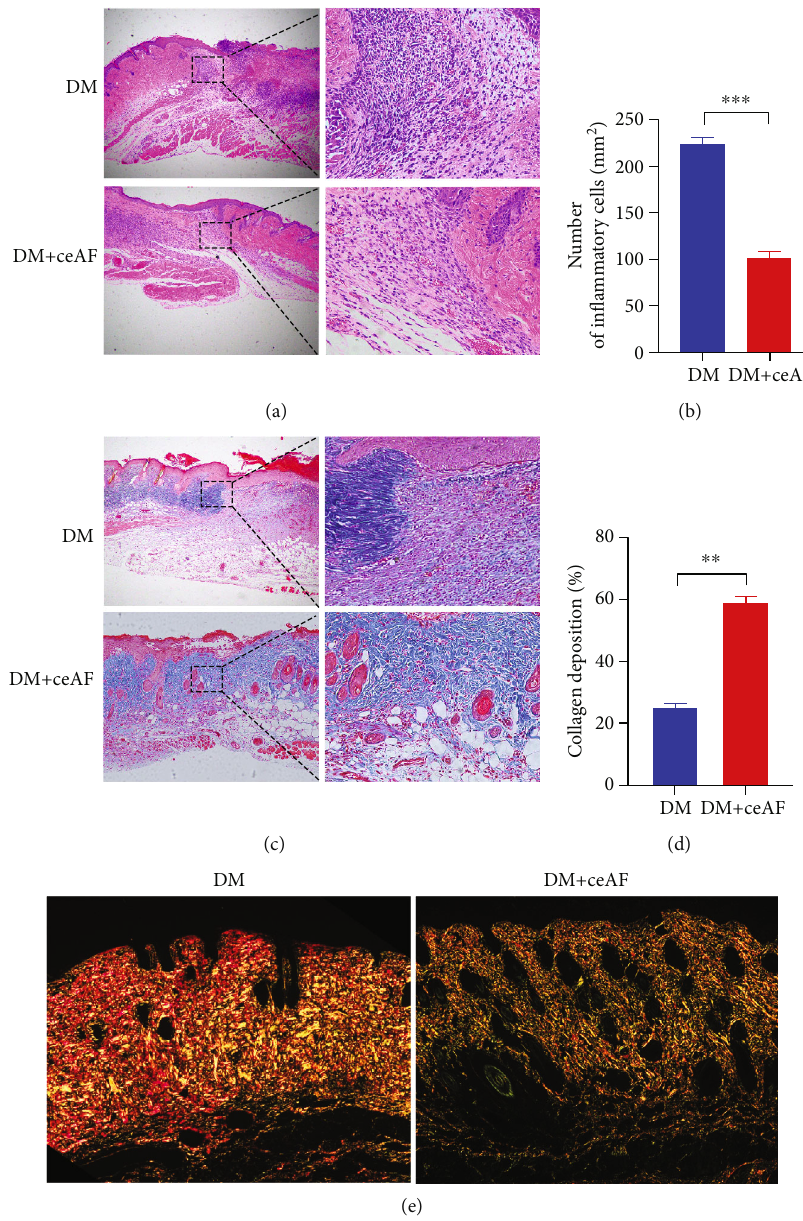
Figure 4: E ff ect of ceAF treatment on the histological changes in wound tissues. (a) H&E staining of skin wounds on day 5 indicated an enhanced in fl ammatory cell in fi ltration in diabetic mice treated with ceAF (Left 40 × , Right 400 × ). (b) Histogram representation of in fl ammatory cell number. (c) MT staining of skin wounds on day 10 indicated an enhanced collagen deposition in the ceAF treatment group (Left 40 × , Right 400 × ). (d) Histogram representation of collagen deposition. (e) Sirius red staining of DM group and ceAF+DM group after healing (40 × ). n = 6 , ∗∗ P < 0 : 01 , ∗∗∗ P < 0 : 001